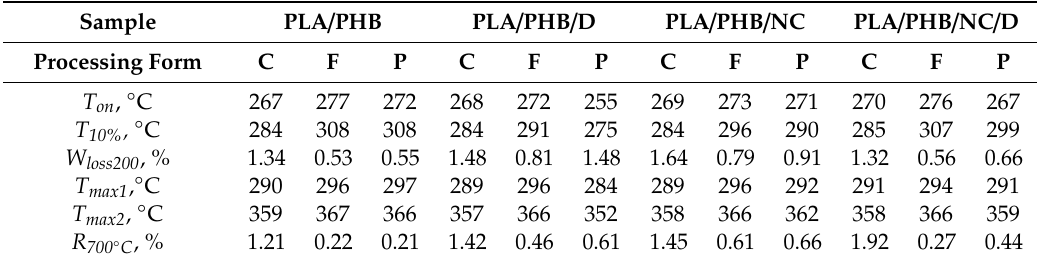
Table 3. TG / DTG data corresponding to PLA / PHB blends and nanocomposites.